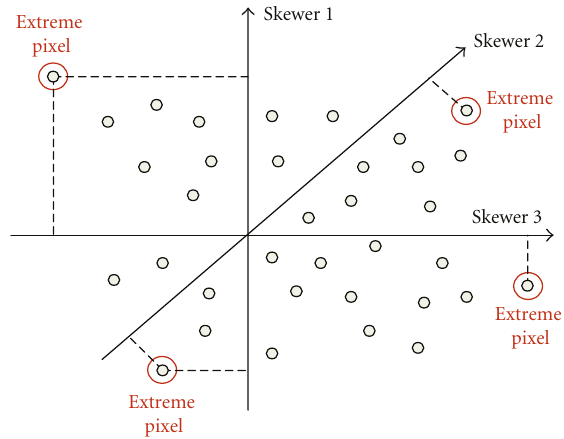
Figure 2: Toy example illustrating the performance of the PPI endmember extraction algorithm in a 2-dimensional